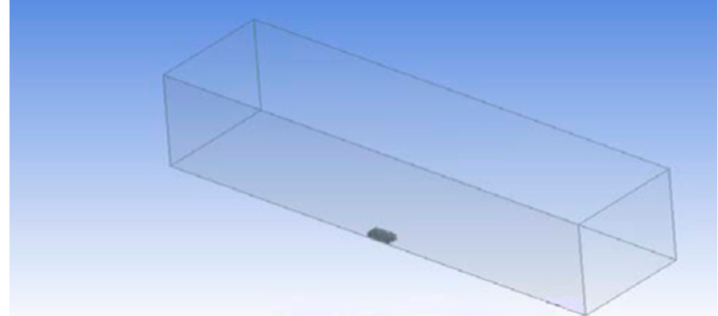
Figure 2. The domain with the heat sink.